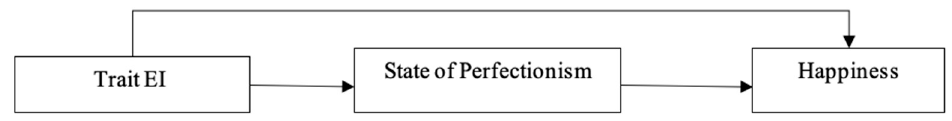
Figure 1. Proposed study framework.